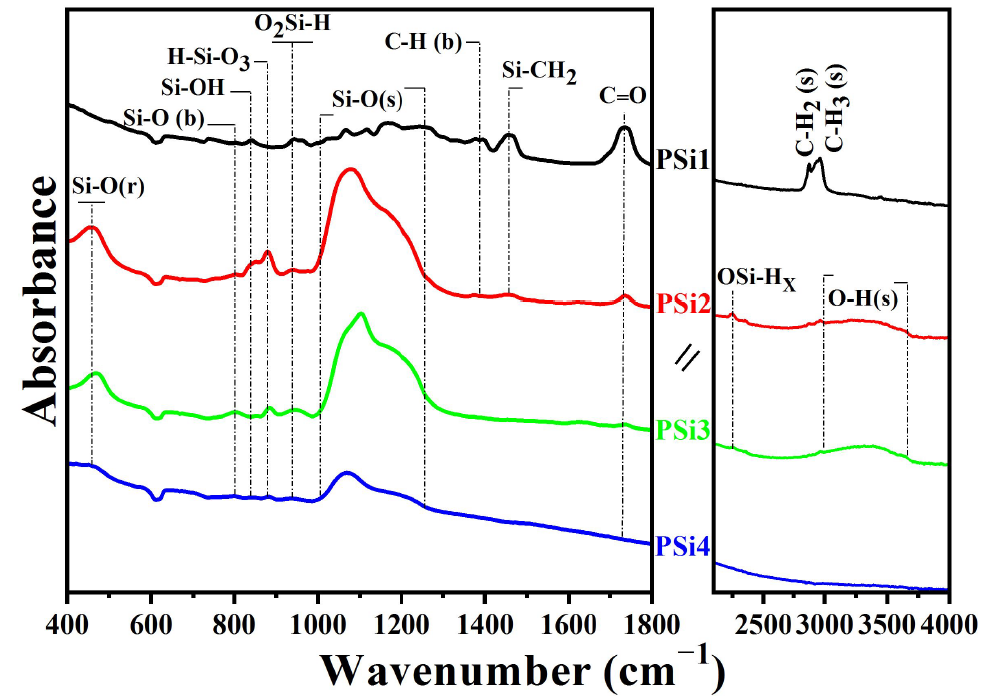
Figure 4. IR absorbance spectra of PSi films.